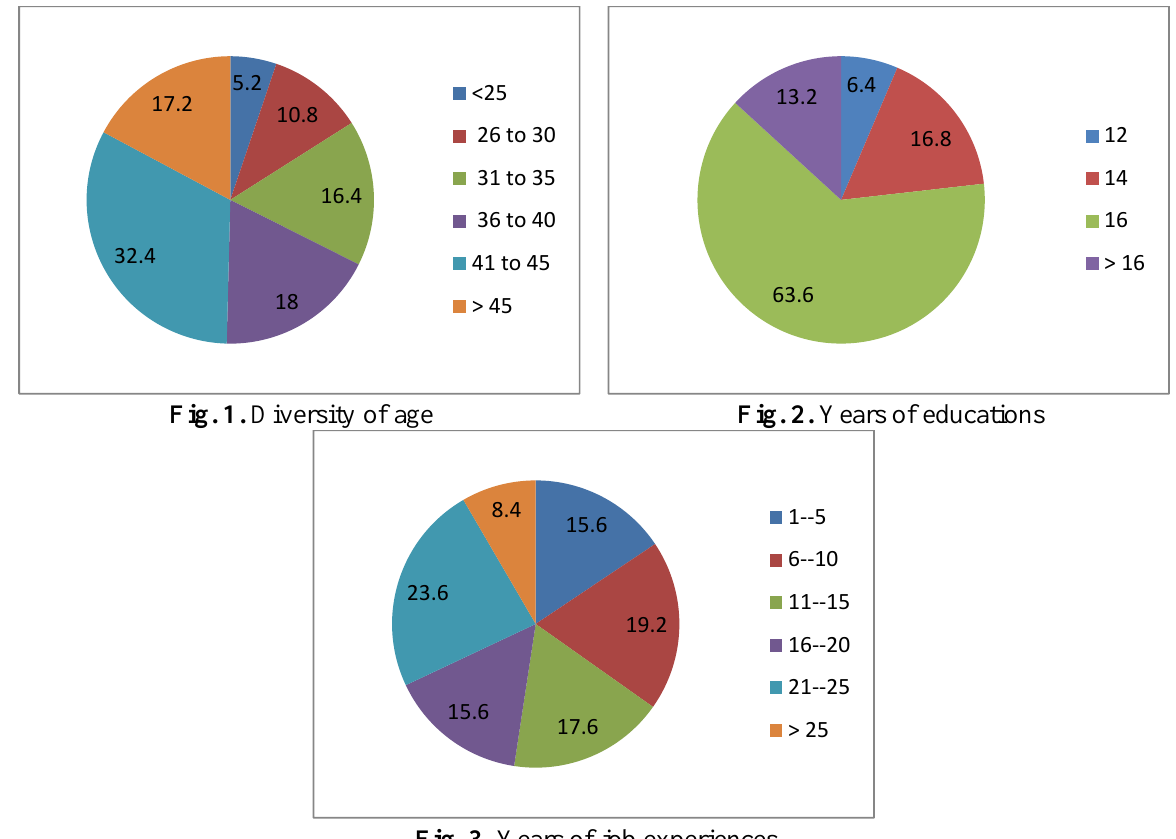
Fig. 1. Diversity of age Fig. 2. Years of educations